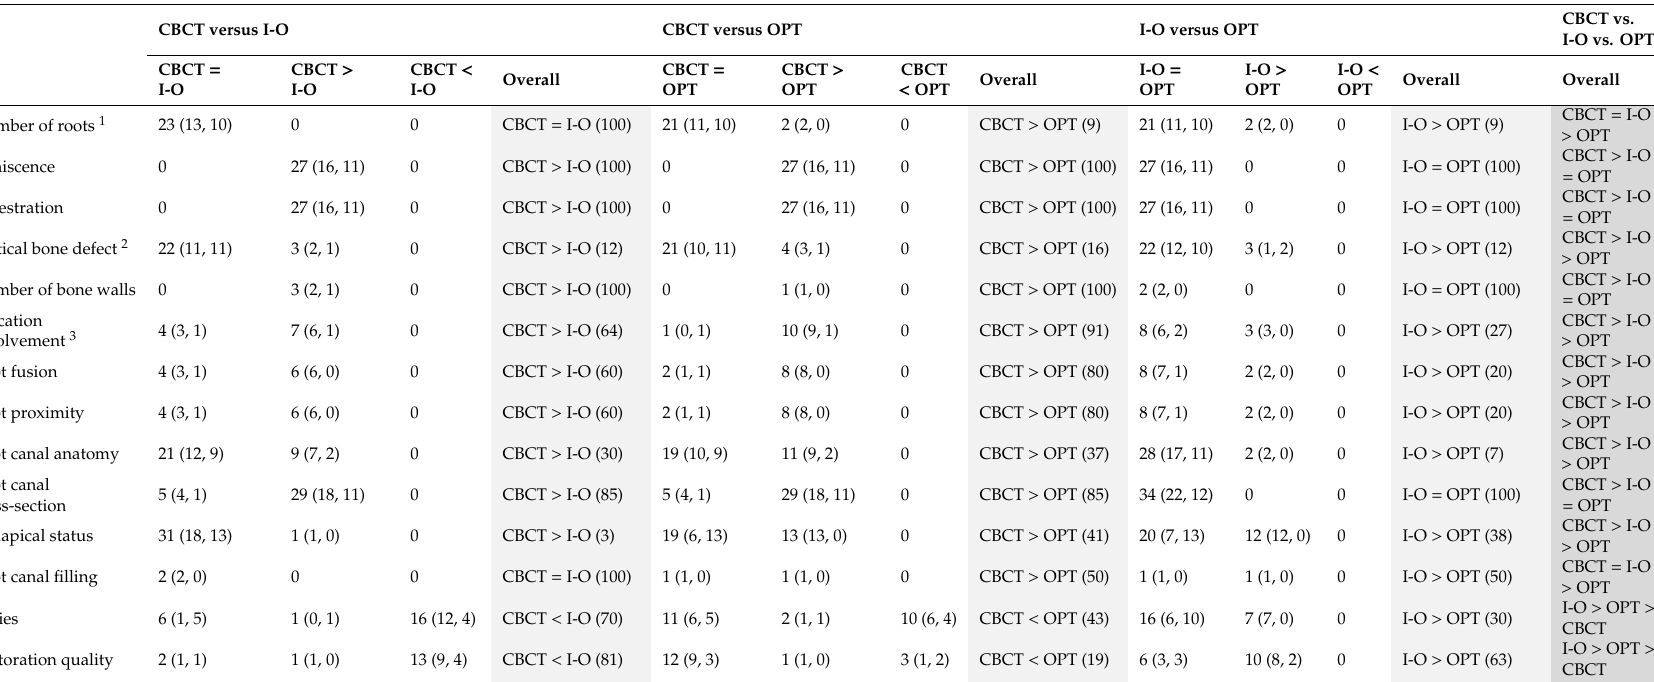
Table 3. Comparison of the results of parameters between the radiographic methods (CBCT versus I-O, CBCT versus OPT, I-O versus OPT), classified as agreement (CBCT = I-O, CBCT = OPT, I-O = OPT), superiority (CBCT > I-O, CBCT > OPT, I-O > OPT) or inferiority (CBCT < I-O, CBCT < OPT, I-O < OPT). For each parameter, the number of all structures (e.g., teeth, roots) assessed, the number of maxillary and mandibular structures separately (in parentheses) and the summary of pairwise (percentage portion of the determining category; highlighted in light grey) and overall comparisons (CBCT versus I-O versus OPT; highlighted in dark grey) are